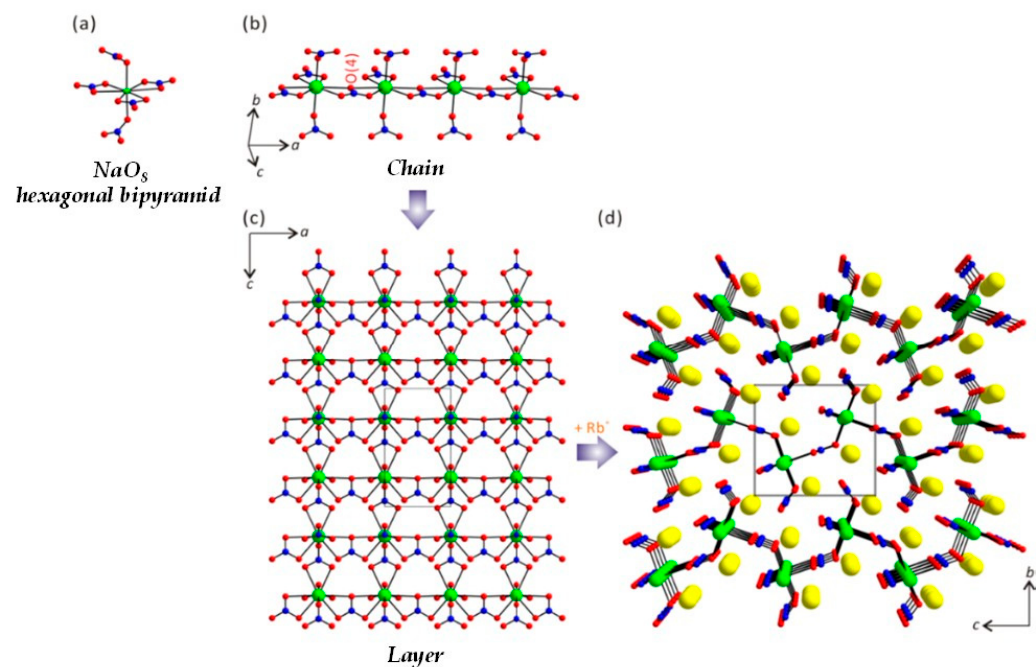
Figure 1. Ball-and-stick model representing ( a ) the NaO 8 hexagonal bipyramid; ( b ) 1D chain along the a -axis; ( c ) one layer in the ac -plane; and ( d ) a complete layered structure in the bc -plane for Rb 2 Na(NO 3 ) 3 (green, Na; blue, N; yellow, Rb; red, O). Note the NO 3 groups serve as intra- and inter-chain linkers.